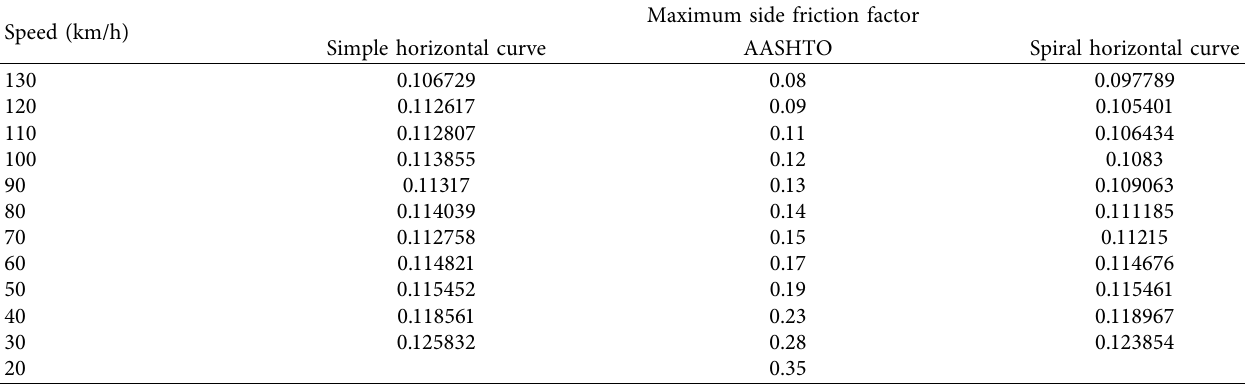
Table 11: Comparison of the maximum side friction factor for a truck between simple and spiral horizontal curves and AASHTO recommended values at a radius of